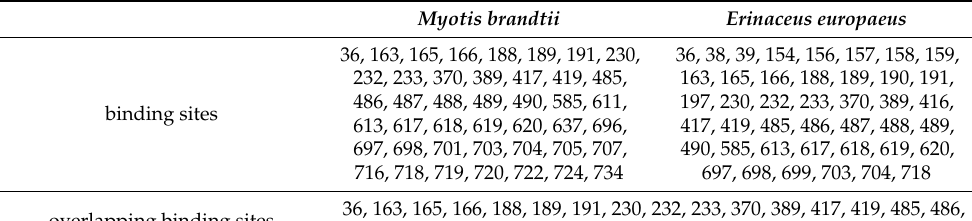
Table 4. Predicted MOW-BatCoV/15-22-DPP4 binding sites of M. brandtii and E. europaeus